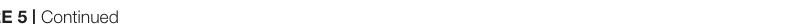
FIGURE 5 | Continued Differences between bacterial phyla in their association with different aquatic environmental conditions. Canonical Correspondence Analysis (CCA) plots are shown, with sampling locations and OTUs ordinated based on the four aquatic environmental parameters shown to significantly affect the microbiome composition. (A) An overview of the ordination, showing the 2845 most abundant OTUs. The following panels each highlight a different aspect of this ordination. (B) The same ordination as in A, with the OTUs removed to show the relative location of the eigenvectors for the aquatic environmental parameters and the ordination of the sampling sites. (C–G) The same plot as in (A) , with specific microbial phyla highlighted. (H,I) Separation in the CCA ordination between selected lineages within the Cyanobacteria (h, orders) and Verrucomicrobia (I, classes). Note the clear separation between the Synechococcales and the Pseudanabaenales and Nostocales along the first CCA axis with some differentiation between the latter two orders primarily along the second CCA axis (h). Within the Verrucomicrobia, the Methylacidiphilae, which are limited to the upper-right hand quadrant, possibly in association with high NO 2 + NO 3 levels, are clearly separated from the other orders, except of the